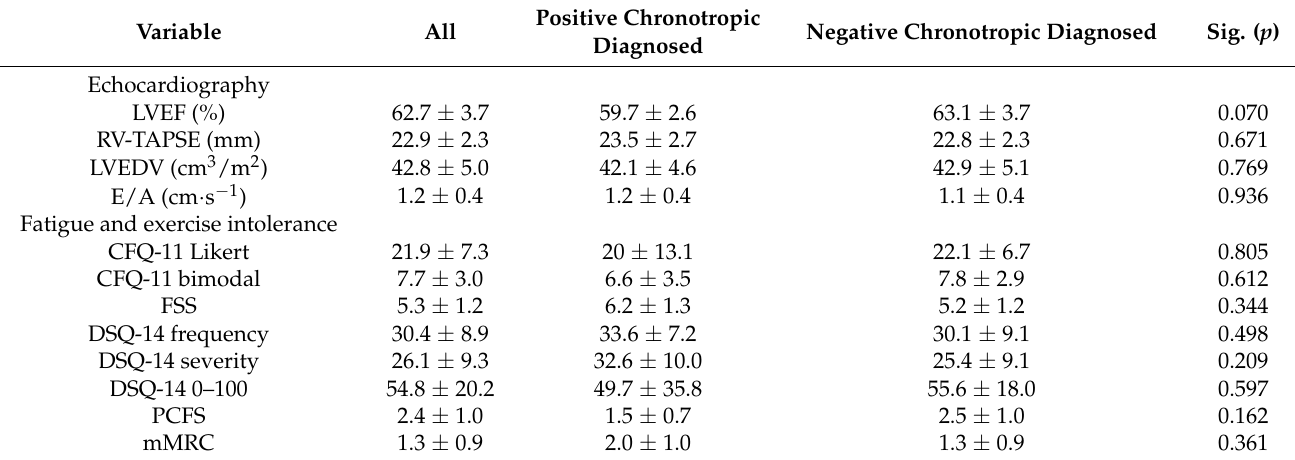
Table 3. Patients with post-COVID19 syndrome and chronotropic incompetence.